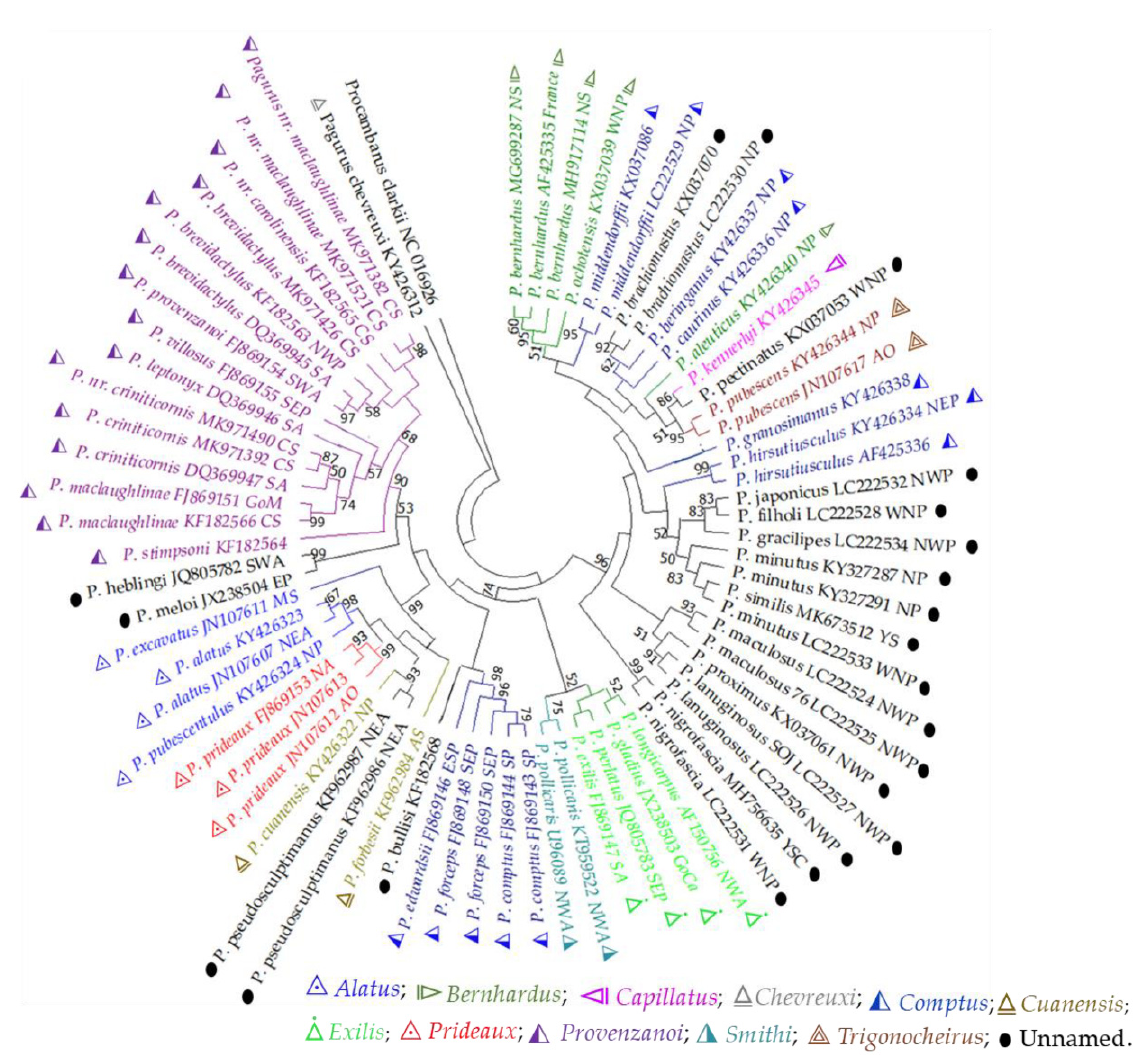
Figure 3. Phylogenetic tree of Pagurus species based on the 16S sequence inferred with the maximum-likelihood (ML) method using T92 + G model. Branch lengths are proportional to inferred nucleotide substitutions. Numbers at nodes represent bootstrap value in percentages; value below 50% are not shown. The species name, accession number, and sampling location are shown for each sequence. Samples were collected from Arctic Ocean (AO), North Sea (NS), North Atlantic (NA), northeast Atlantic (NEA), northwestern Atlantic (NWA), Caribbean Sea (CS), Mediterranean Sea (MS), Gulf of Mexico (GoM), South Atlantic (SA), southwest Atlantic (SWA), North Pacific (NP), East Pacific (EP), northeast Pacific (NEP), northwest Pacific (NWP), southeast Pacific (SEP), Yellow Sea China (YSC), Yellow Sea South Korea (YSSK), East China Sea (ECS), South China Sea (SCS), Sea of Japan (SOJ), and Indian Ocean (IO). Different colors represent the morpho-based species groups.